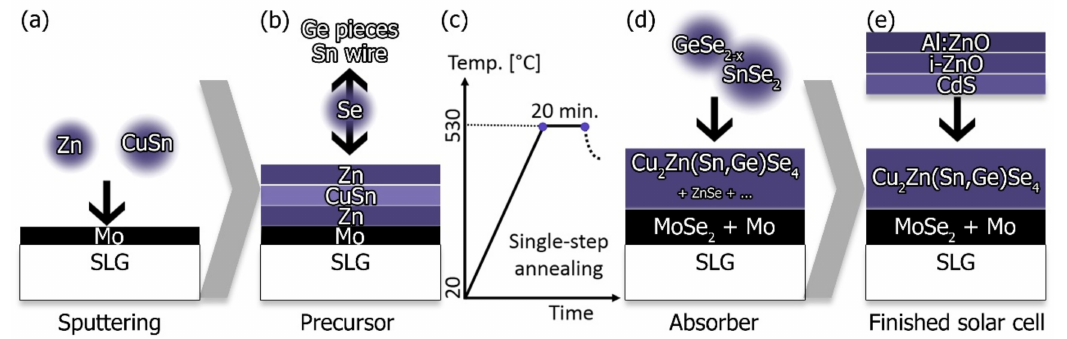
Figure 1. Sample preparation steps: ( a ) Sputtering of Zn and Cu-Sn, ( b ) precursor stack annealed under Se atmosphere with Sn wire and Ge pieces, ( c ) performed temperature profile, ( d ) (simplified) reaction scheme, and ( e ) the solar-cell finishing